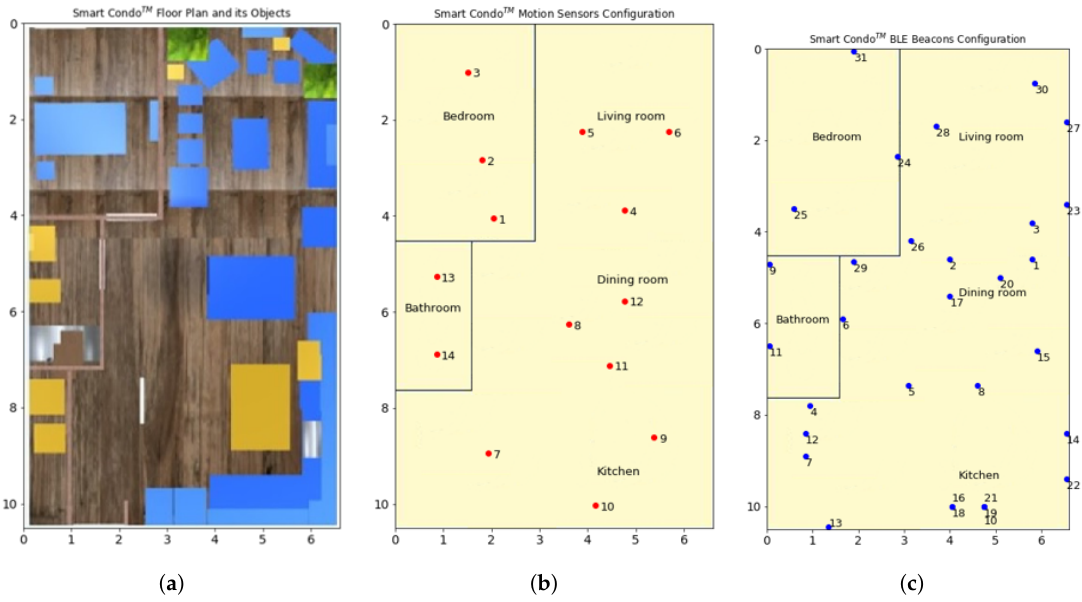
Figure 2. Our testbed and configuration of motion sensors and Bluetooth Low Energy (BLE) beacons. ( a ) 3D model of the Smart Condo™ in BIM Sim , and its objects. ( b ) Motion sensor configuration in 3 D our testbed; each with an ID beside it, ( c ) BLE beacon configuration in our testbed; each with an ID beside